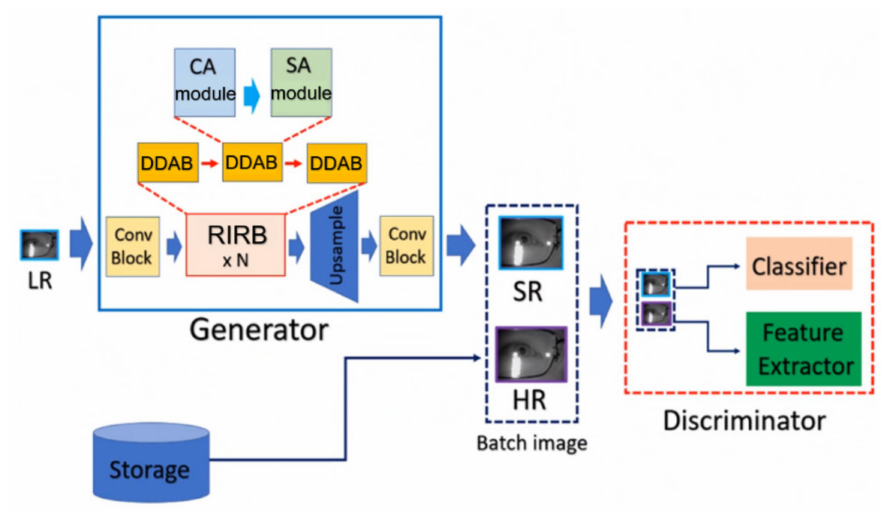
Figure 1. DDA-SRGAN architecture. DDA-SRGAN is a GAN-based approach, which is composed of the generator and the discriminator. In the generator, the ROI feature will be extracted from the LR images by the high-capacity block RIRB, and the informative embedding will be used to generate the accurate SR images by the bicubic-convolution upsampling [14]. On the other hand, the framework is similar to the previous work